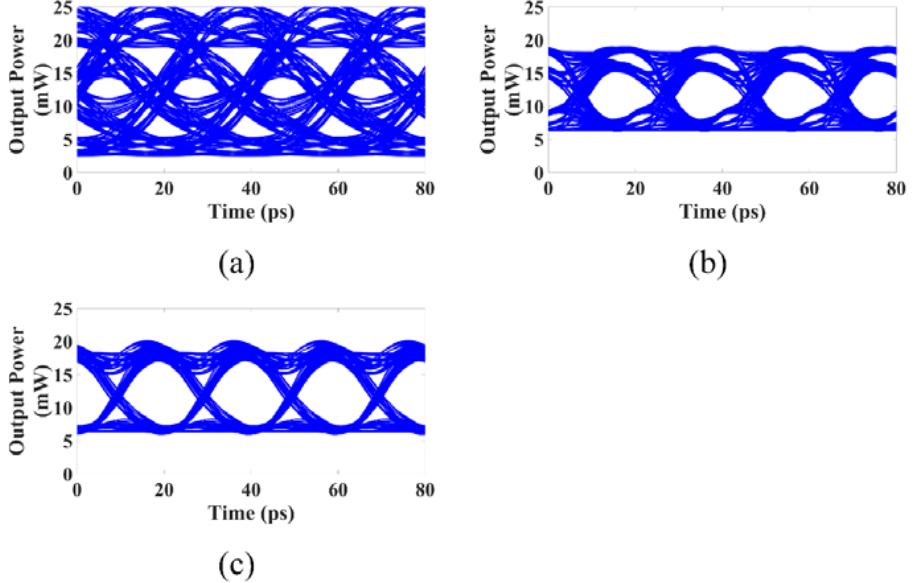
P mW : ( a ) Conventional DML; ( b ) PPM-DFB bias